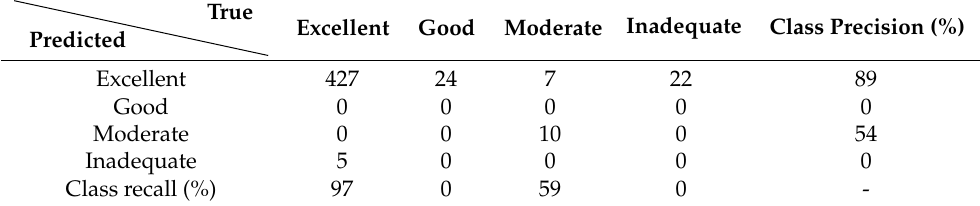
Table 5. Confusion matrix of the random-tree algorithm applied to the rearing environment dataset.